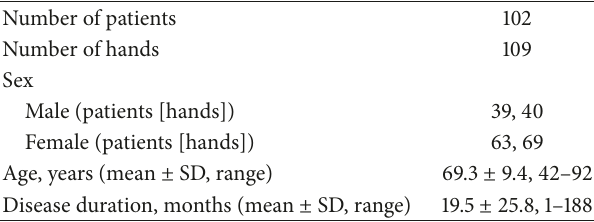
Table 1: The demographic characteristics of the study participants. Number of